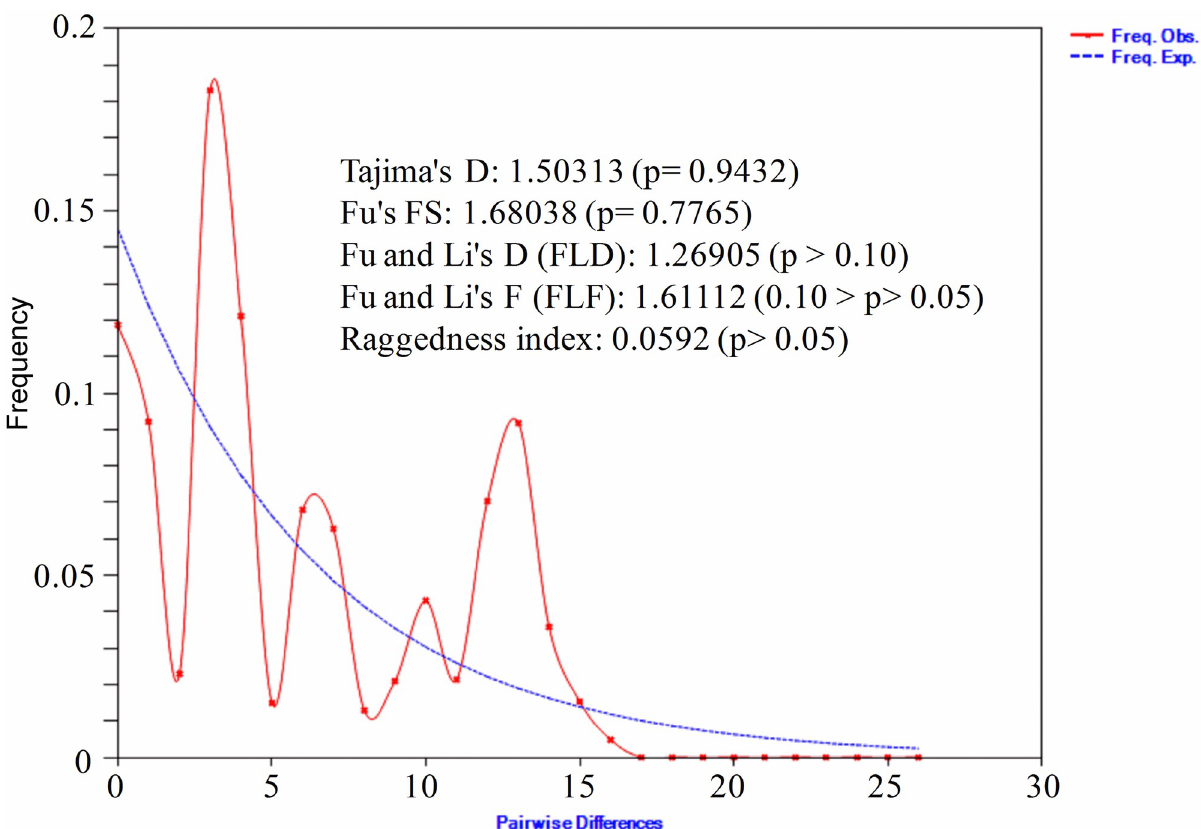
Fig 8. Mismatch distribution graph and neutrality tests of Andaman local ducks. The x and y axis presents number of pairwise differences and the frequency of the pairwise comparisons respectively.